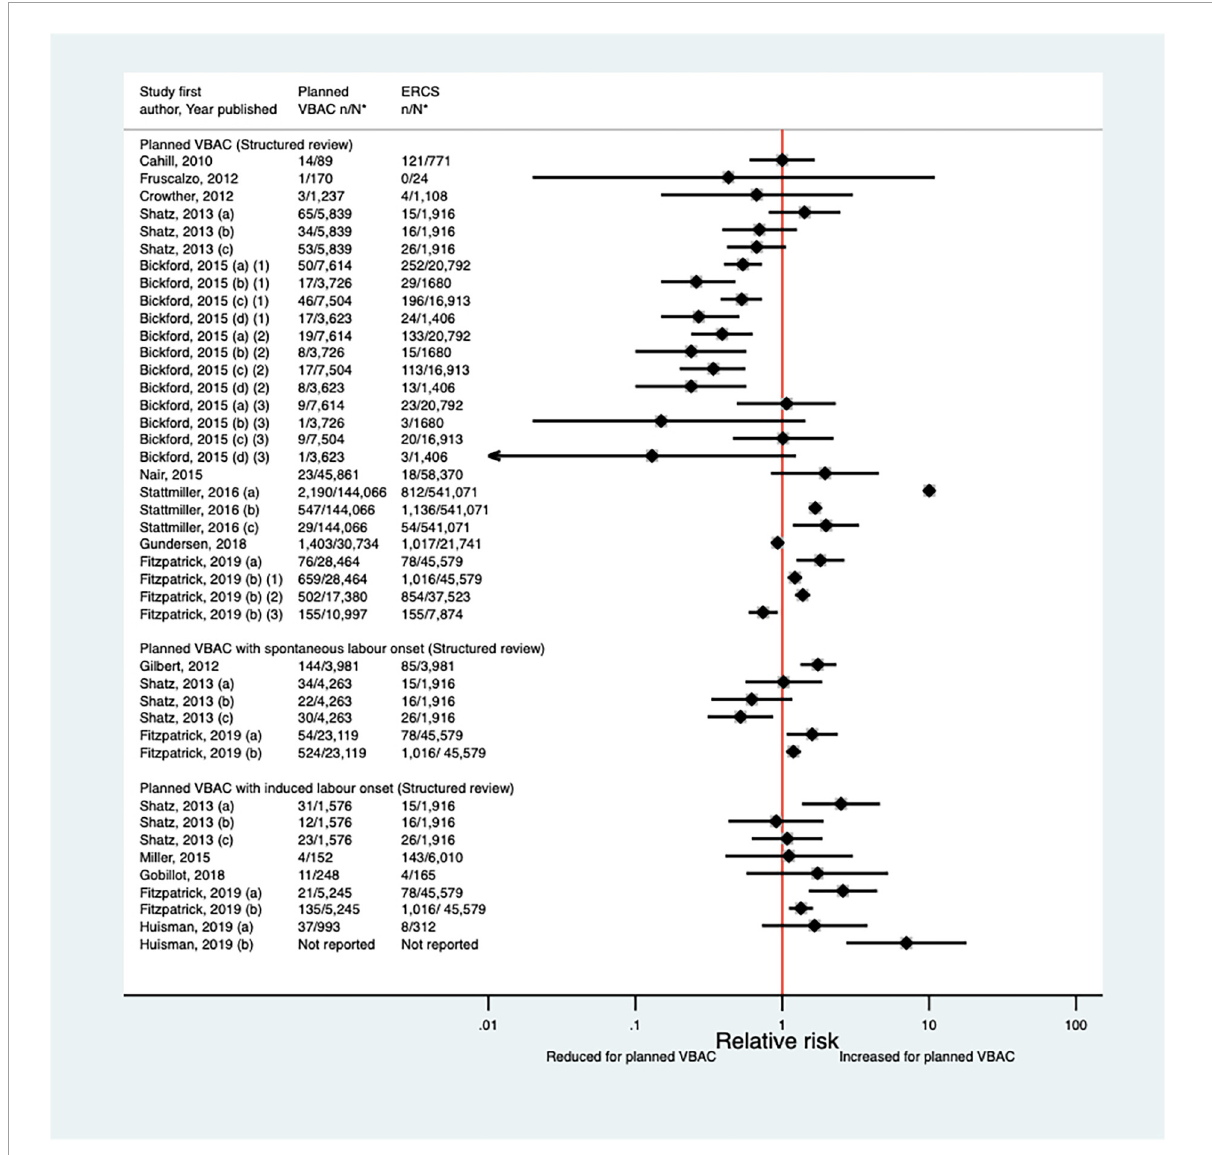
FIGURE5 Risk of any type of maternal infection for planned VBAC vs. ERCS. * n , number in group with the outcome; N , Total number in group. Shatz et al. (47) (a) outcome: postpartum infection, (b) outcome: endometritis, (c) outcome: fever; Bickford and Janssen (50) (a) risk in women with 1–2 prior CSs only, (b) risk in women with 1–2 prior CSs and ≥ 1 prior VB, (c) risk in women with 1 prior CS only, (d) risk in women with 1 prior CS and ≥ 1 prior VB, (1) outcome: obstetric surgical wound infection, (2) outcome: puerperal infection, (3) outcome: puerperal sepsis; Stattmiller et al. (55) (a) outcome: chorioamnionitis, (b) outcome: major puerperal infection, (c) outcome: puerperal sepsis; Shatz et al. (47) (a) outcome: infection, (b) outcome: endometritis, (c) outcome: fever; Fitzpatrick et al. (65) (a) outcome: puerperal sepsis, (b) outcome: other